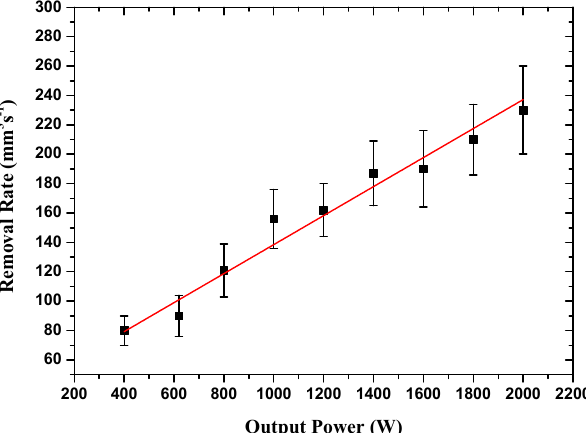
Figure 4. The removal rate of the EP paint achieved with the laser output power.